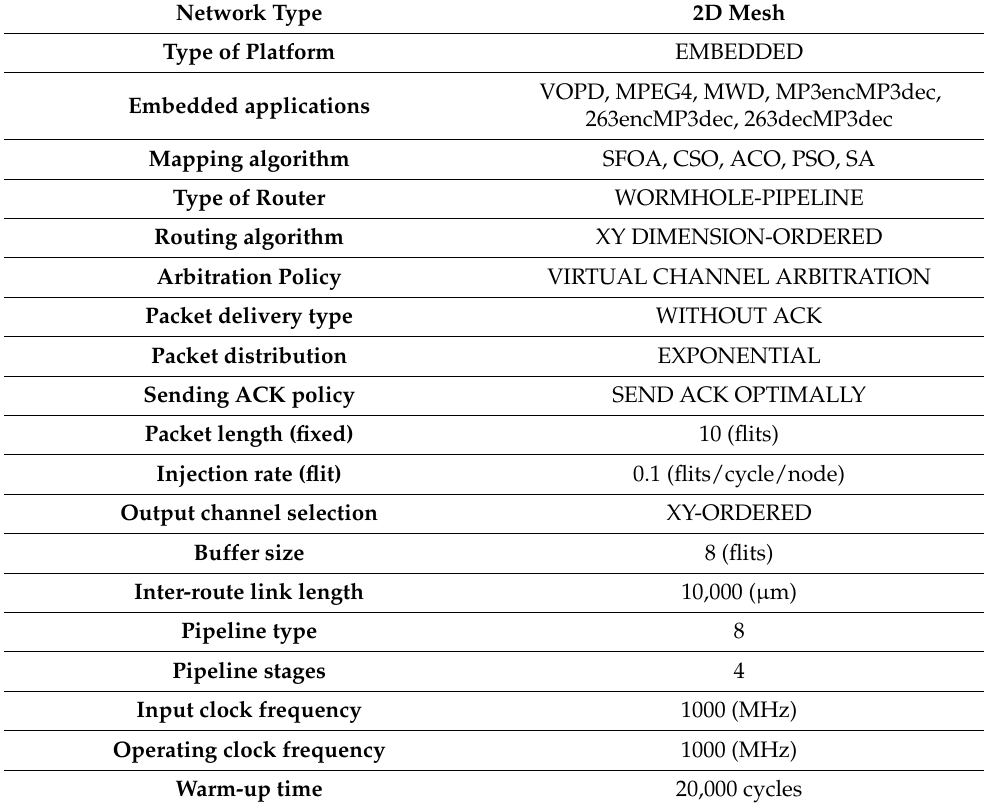
Table 2. Simulation environment